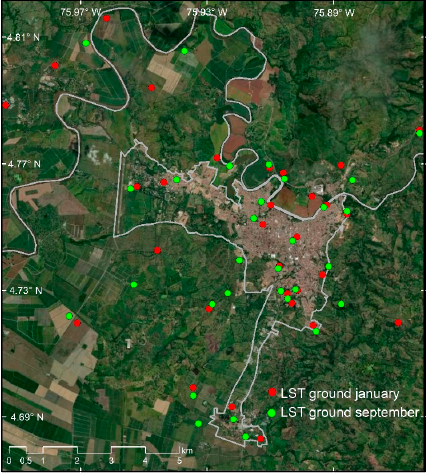
Figure 4. Location of in situ ground LST measurements.